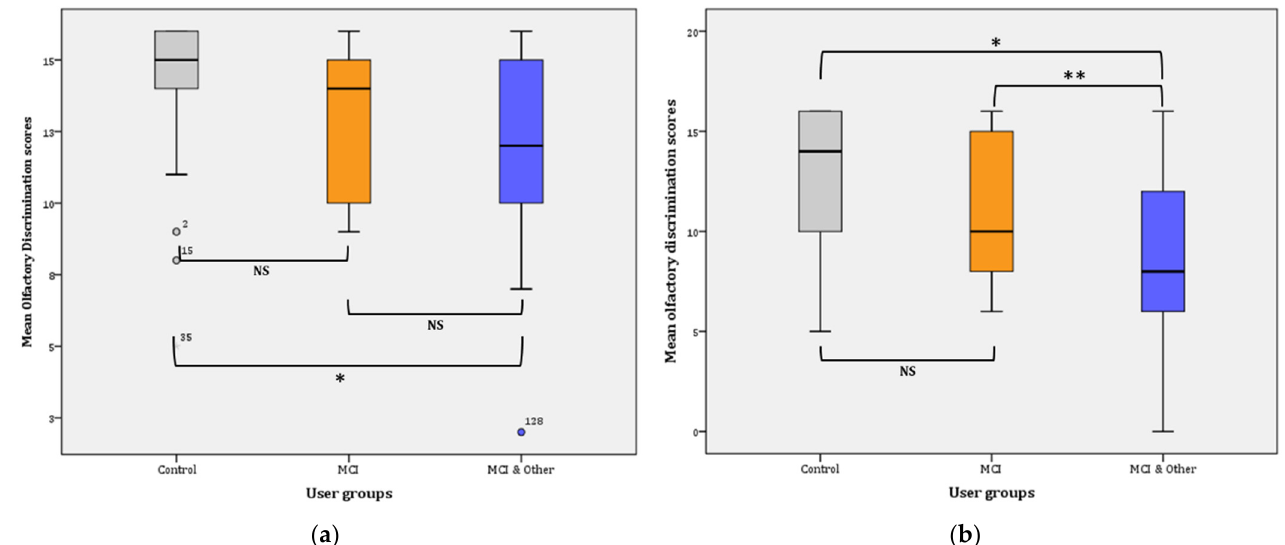
Figure 3. Mean olfactory discrimination scores: ( a ) for Phase I; * p < 0.001. ( b ) for Phase II; * p < 0.001, ** p = 0.016. NS: non-significant.